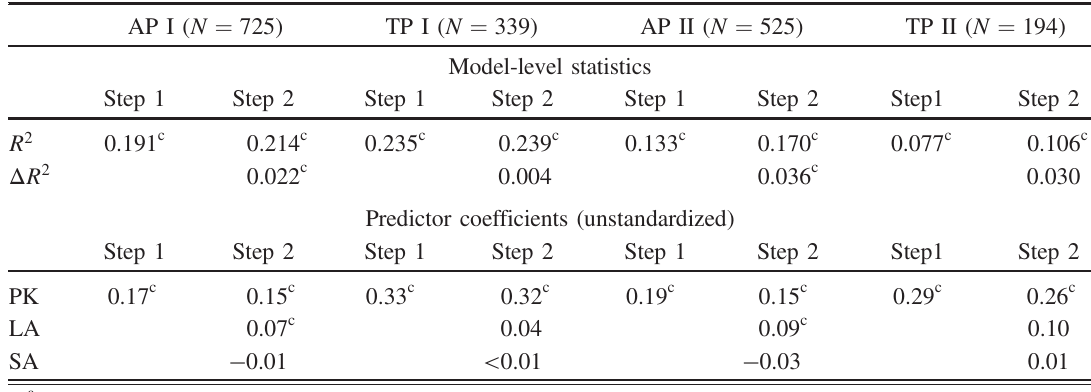
late-semester concept inventories as the dependent measure, and Table VII shows analyses with exam performance as the dependent